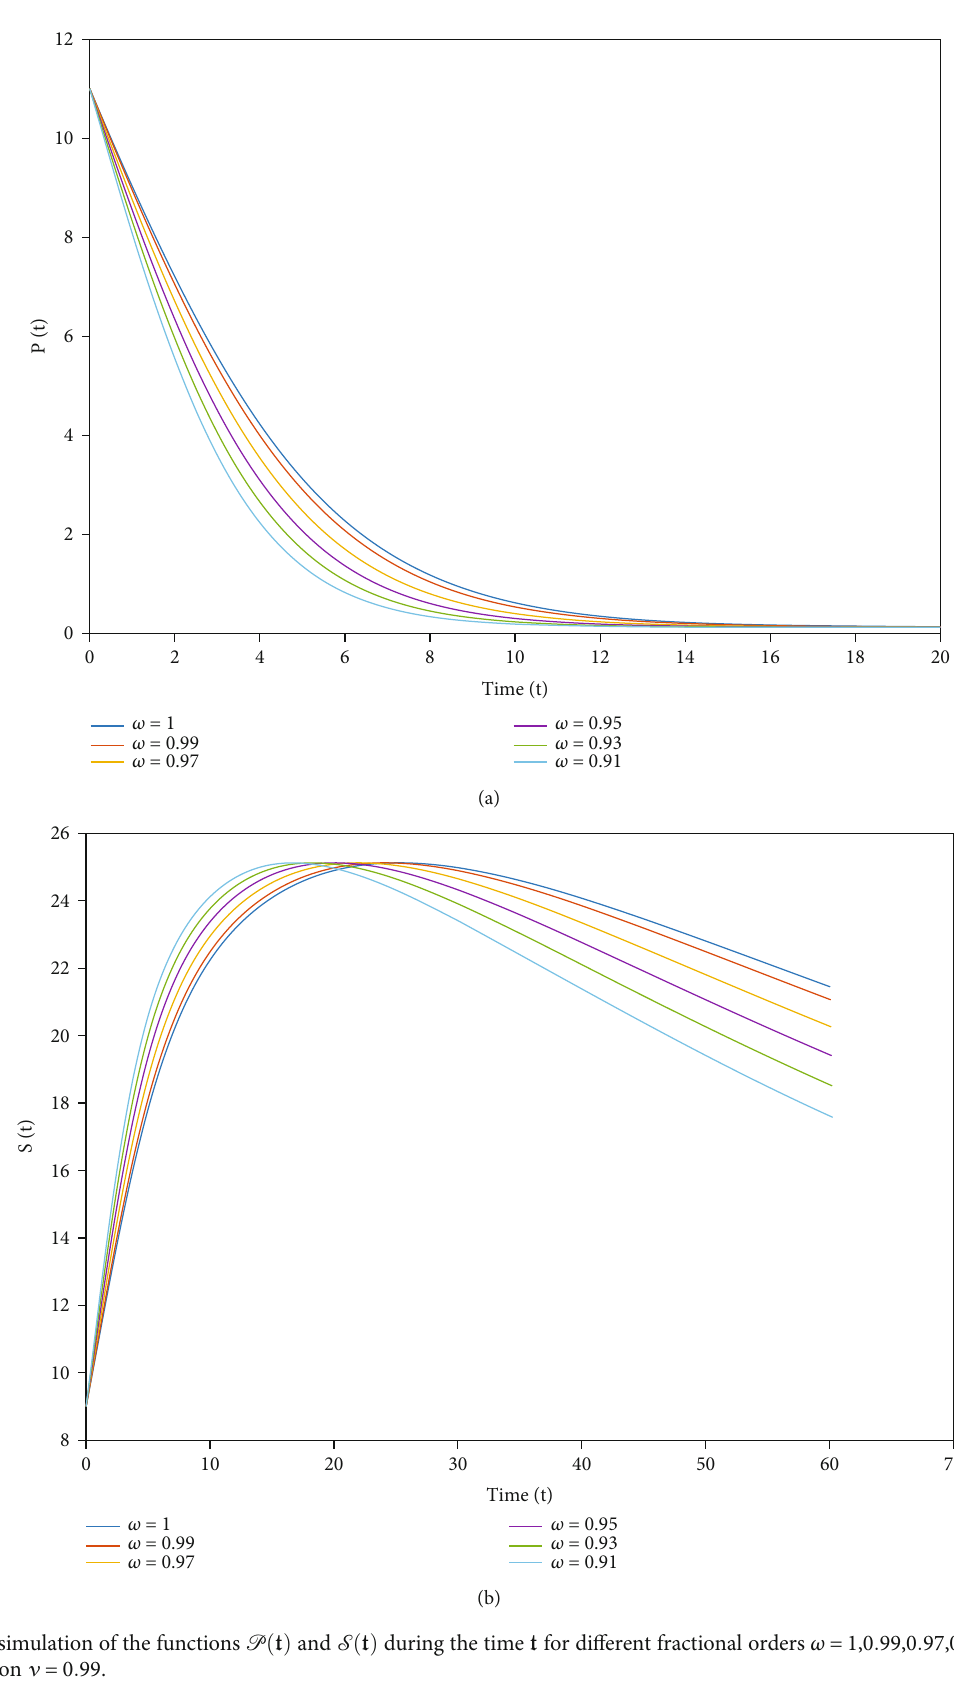
Figure 8: The simulation of the functions P ð t Þ and S ð t Þ during the time t for di ff erent fractional orders ω = 1,0 : 99,0 : 97,0 : 95,0 : 93,0 : 91 and fractal dimension ν = 0 : 99